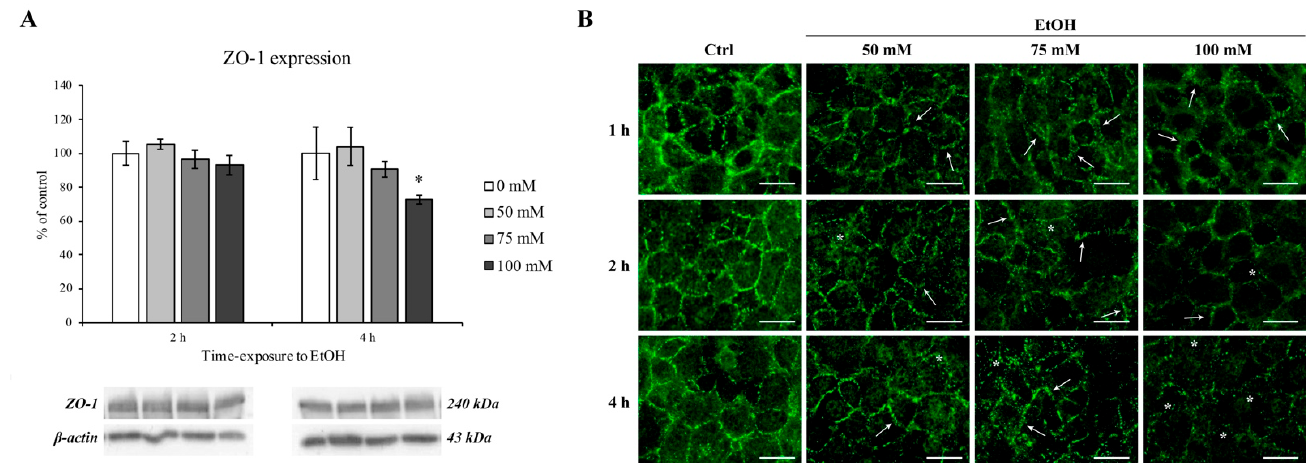
Figure 8. ZO-1 expression and immunofluorescent staining on RBE4 cells after EtOH treatment. ( A ) Western blotting analysis and quantification of ZO-1 after EtOH (50, 75 and 100 mM) exposure at 2 and 4 h. Values are expressed in percentage of control (untreated cells) as the mean ± S.E.M. of three independent experiments in triplicate. * p < 0.05 vs. control. ( B ) Changes in ZO-1 distribution were evaluated after EtOH (50, 75 and 100 mM) treatments at 1, 2, and 4 h in comparison to control (untreated cells). Arrows show the “zip-like” structure as indicative for morphological alterations in intercellular junctions. Asterisks show the presence of holes formed between endothelial cells. Scale bar: 25 µm.